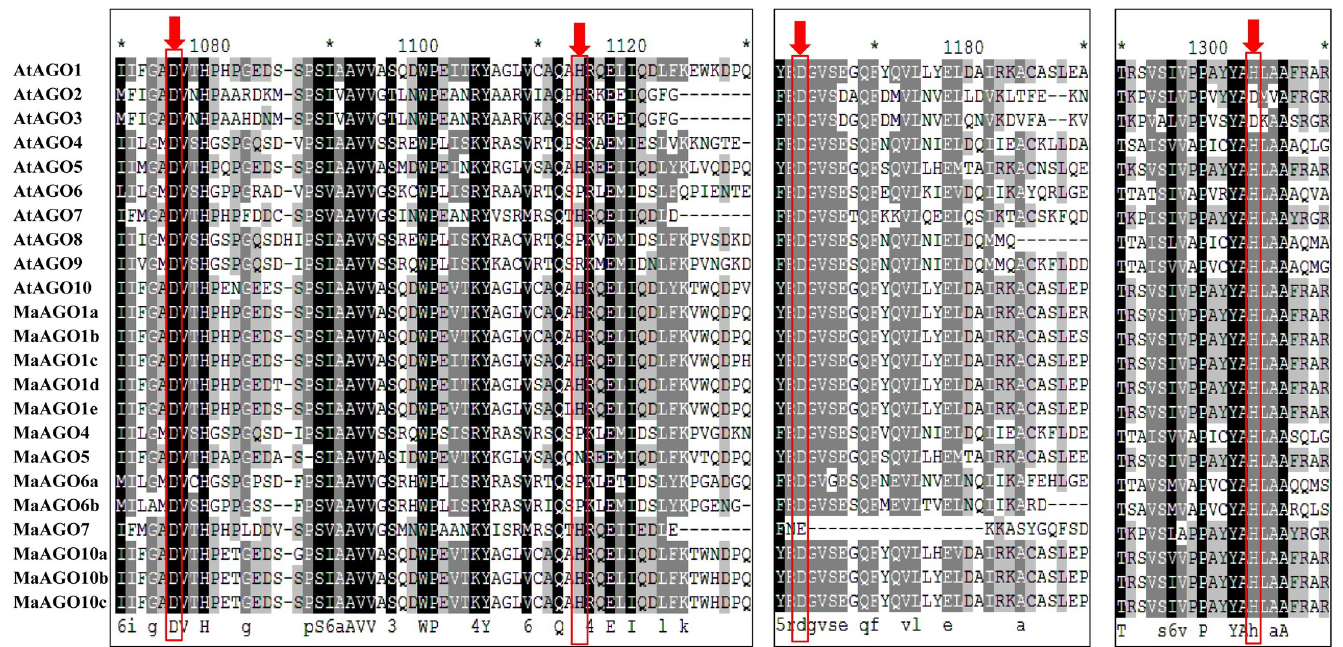
Fig 3. PIWI domain of the aa sequences of M . acuminata and Arabidopsis AGO proteins by Clustal-W program in MEGA 11. The downward red arrows indicatethe conserved DDH triad of PIWI domain and the conserved H798 positions.